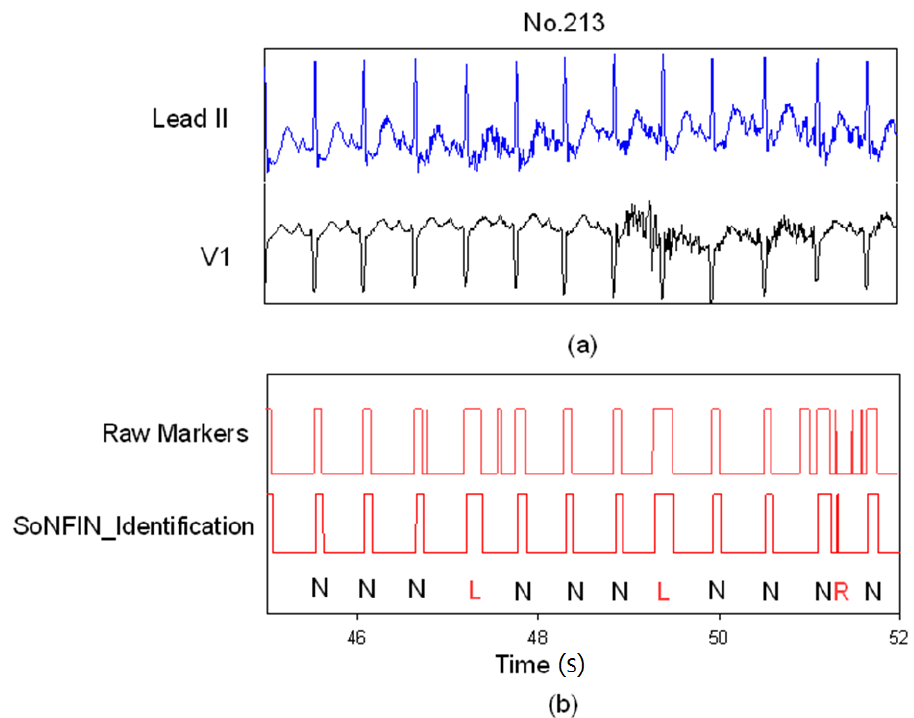
Figure 7. SoNFIN filters the mistaken markers for file No. 231, ( a ) the raw Lead II and V1 signals; ( b ) the raw markers by SVM and the filtered Markers by